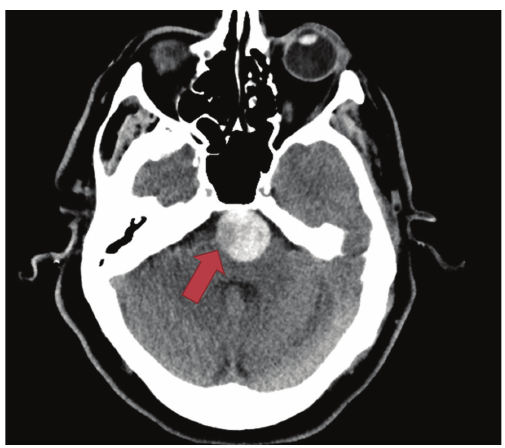
Figure 1: CT head without contrast: 25mm basilar artery aneu- rysm with partial thrombosis and no evidence of rupture.